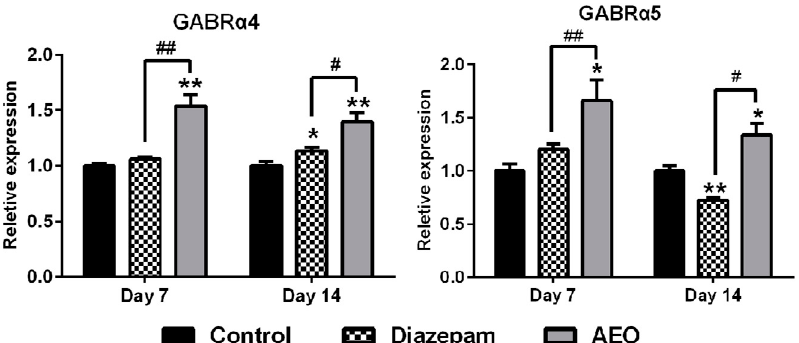
Figure 8. Effects of AEO (60 mg/kg) and diazepam (5 mg/kg) on mRNA expression of GABA A receptor subunits and subtypes in mice. Values are represented as mean ± SEM. Results are representative of three independent experiments with n = 3. * p < 0.05 and ** p < 0.01 vs. control. # p < 0.05 and ## p < 0.01 vs. diazepam group at the corresponding time.